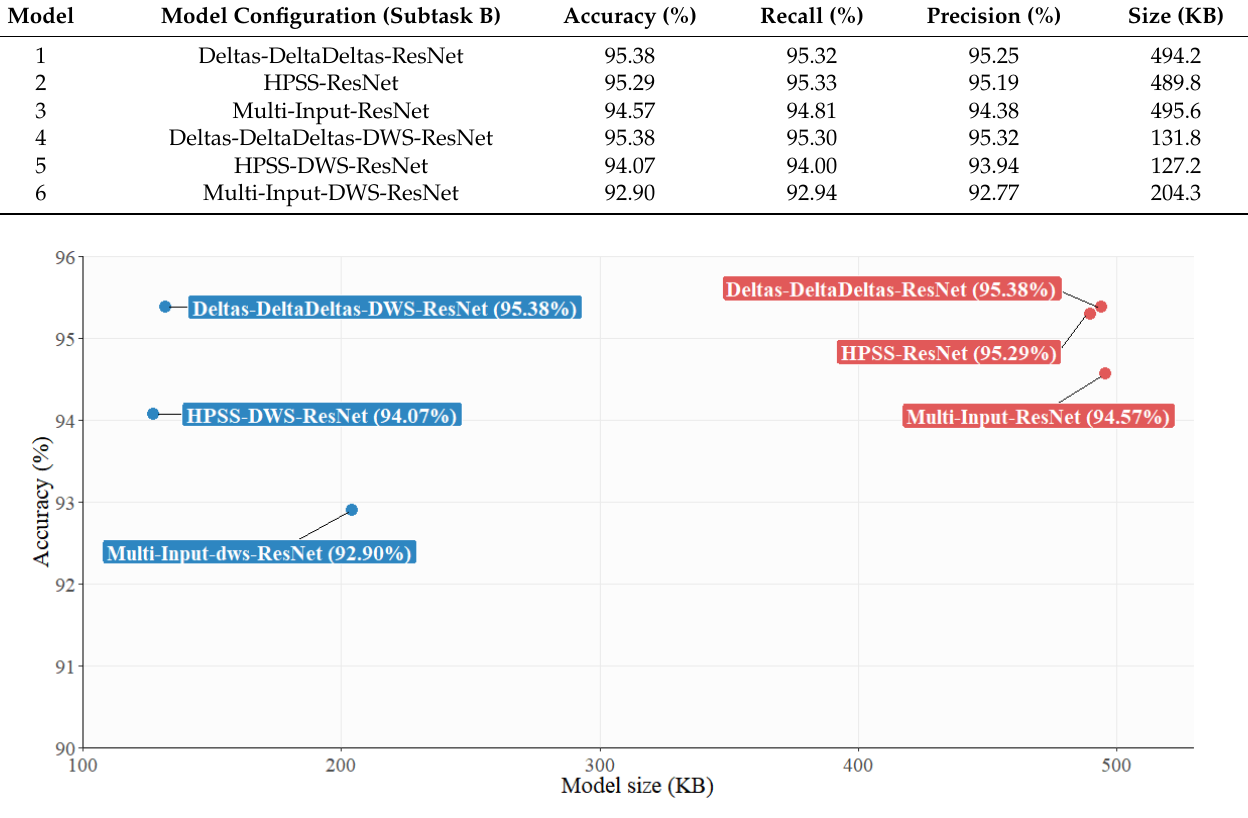
Figure 5. Graph comparing the model size and performance of subtask B. The blue dots are the models to which the weight reduction technique is applied, and the red dots are the original